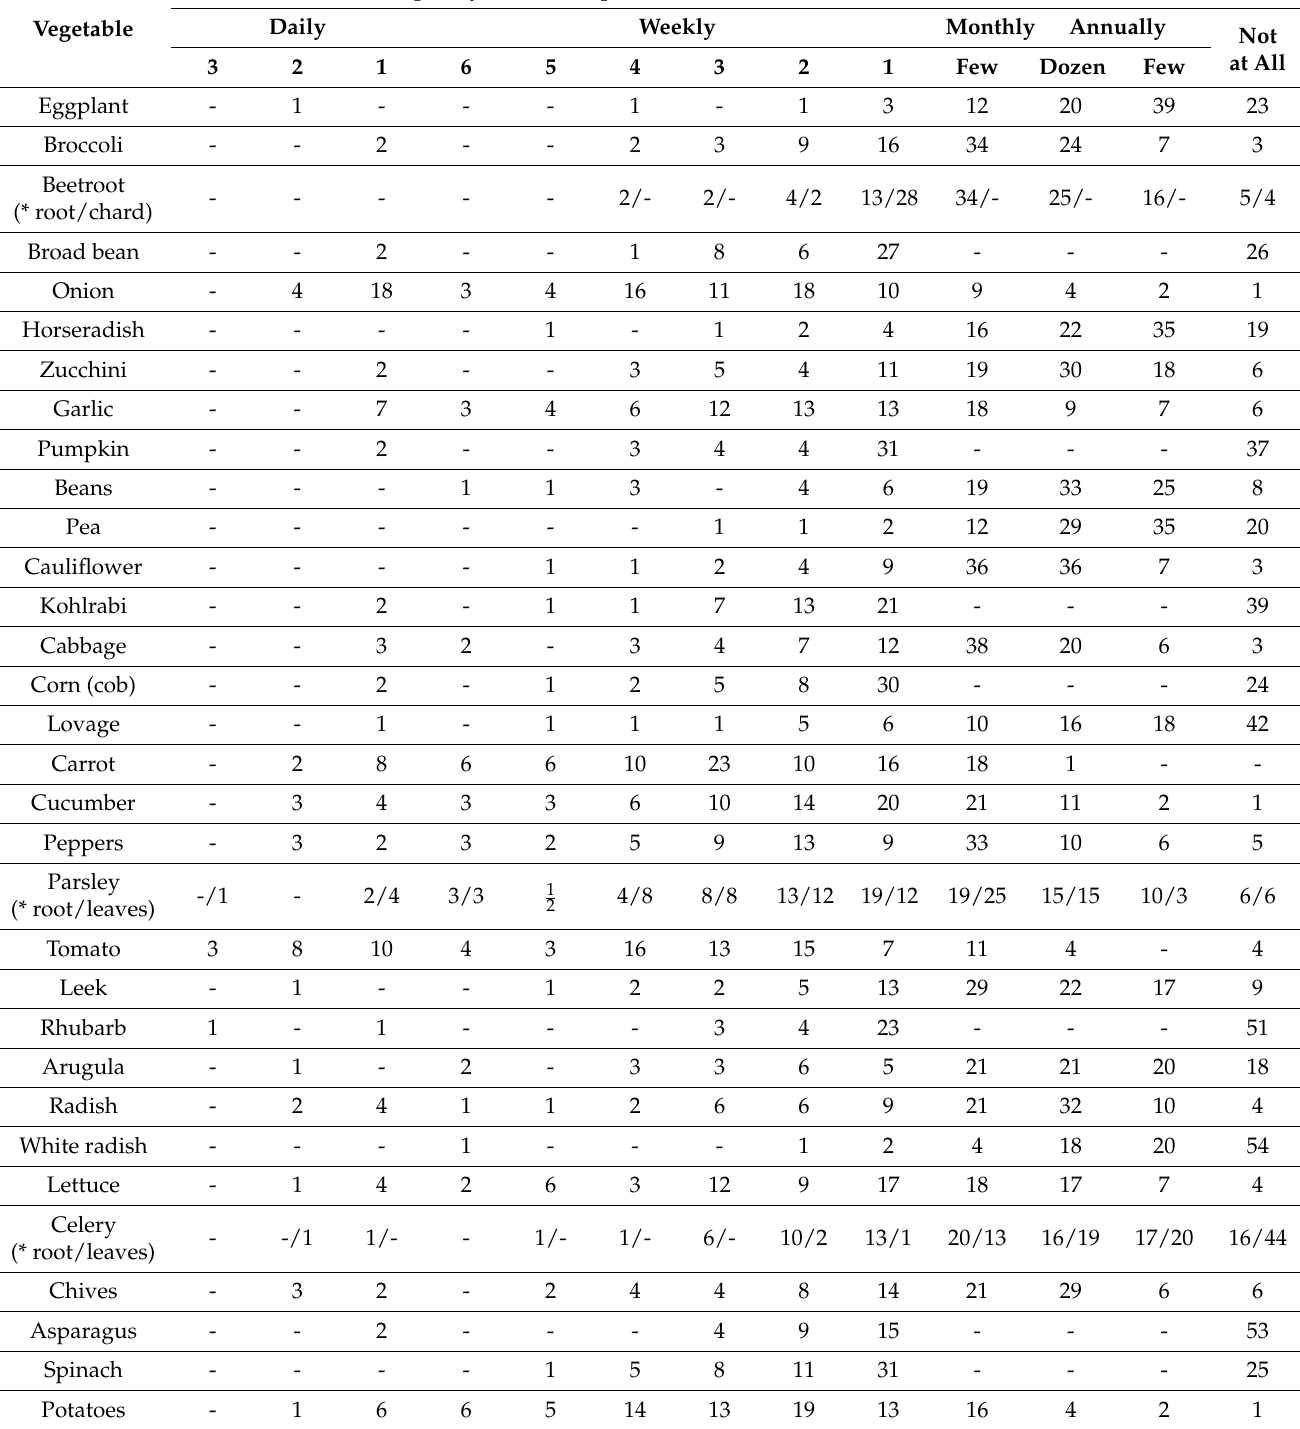
Table 3. The frequency of vegetable intake grown in Poland